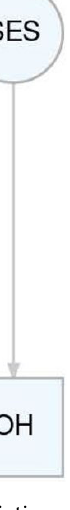
Figure 5. Mediation analysis of oral hygiene (OH), SES and coordinative abilities.